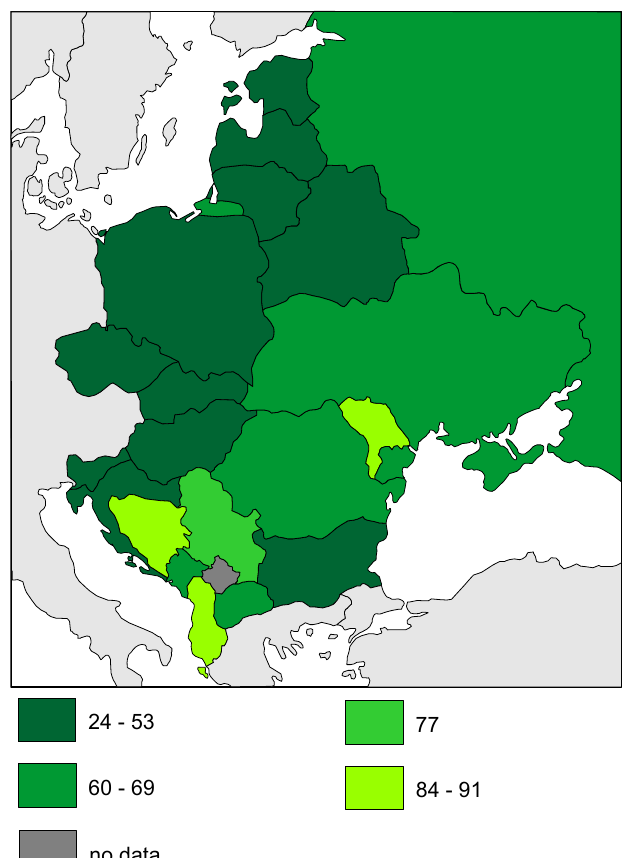
Fig. 1. Location of European post-Communist countries according to the Legatum Prosperity Index in 2014 (source: